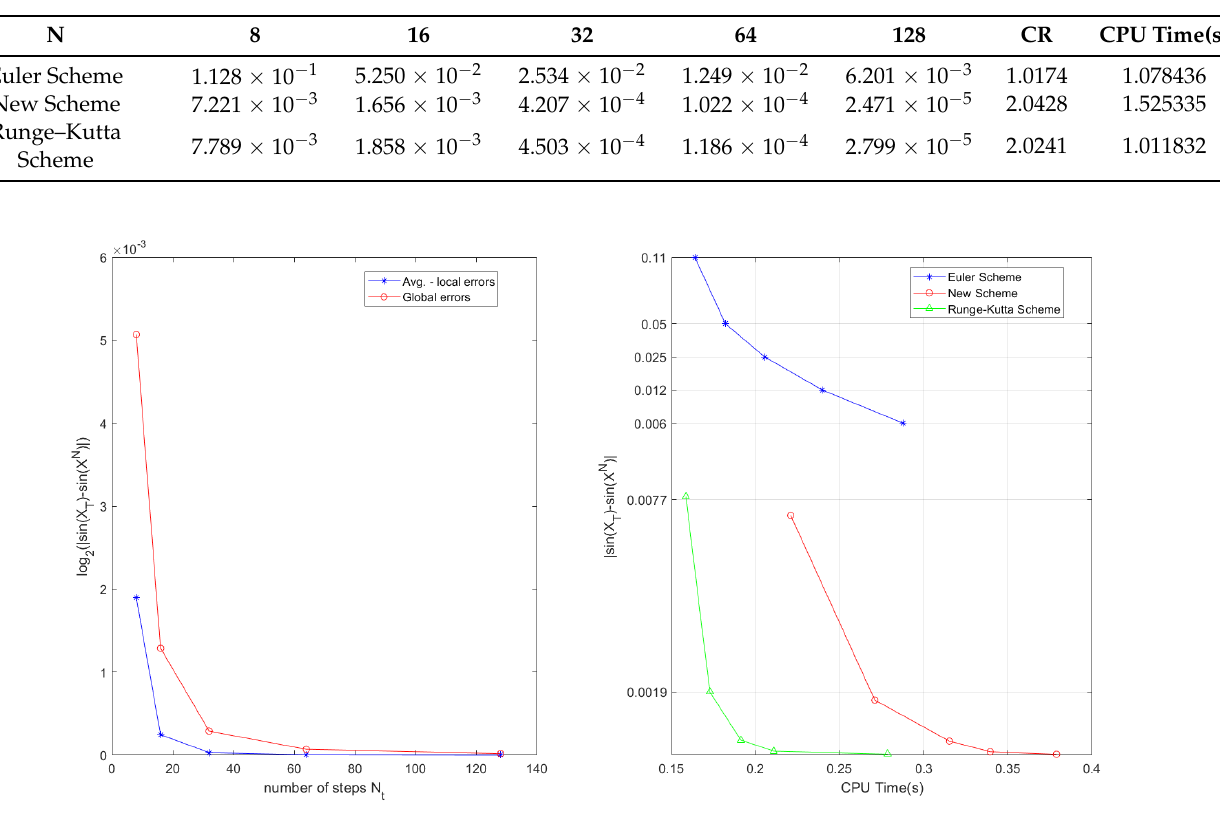
Table 2. Errors and convergence rates of all schemes with the parameters of X 0 = 5, f ( 1 ) = 1.65, g ( 1 ) = 0.05, f ( 2 ) = 1.8, g ( 2 ) = 0.02.